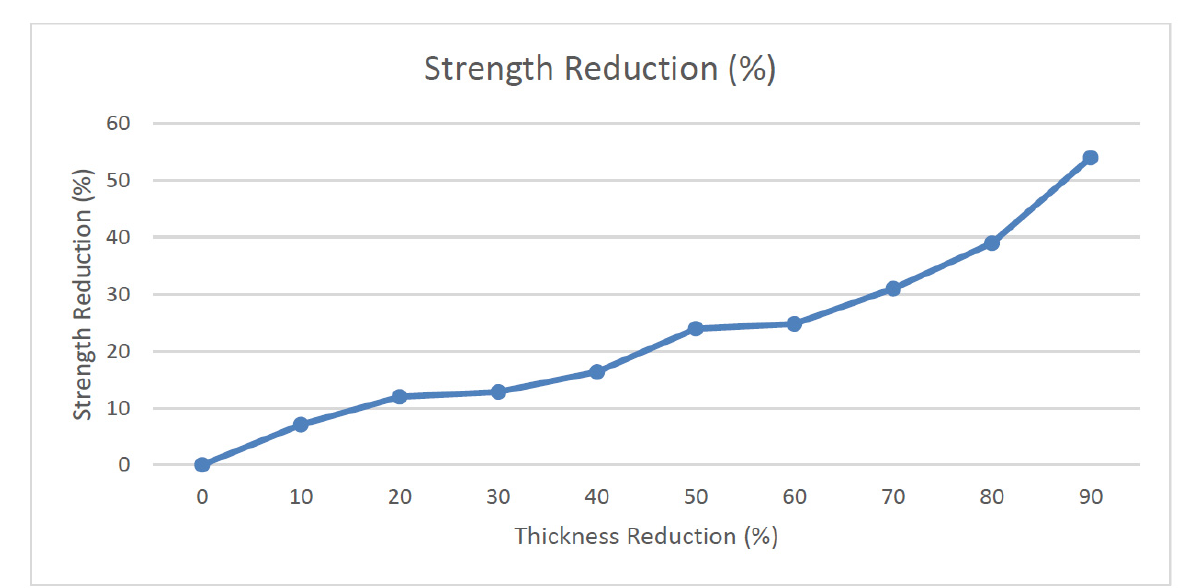
Figure 17. Data Gathering Process